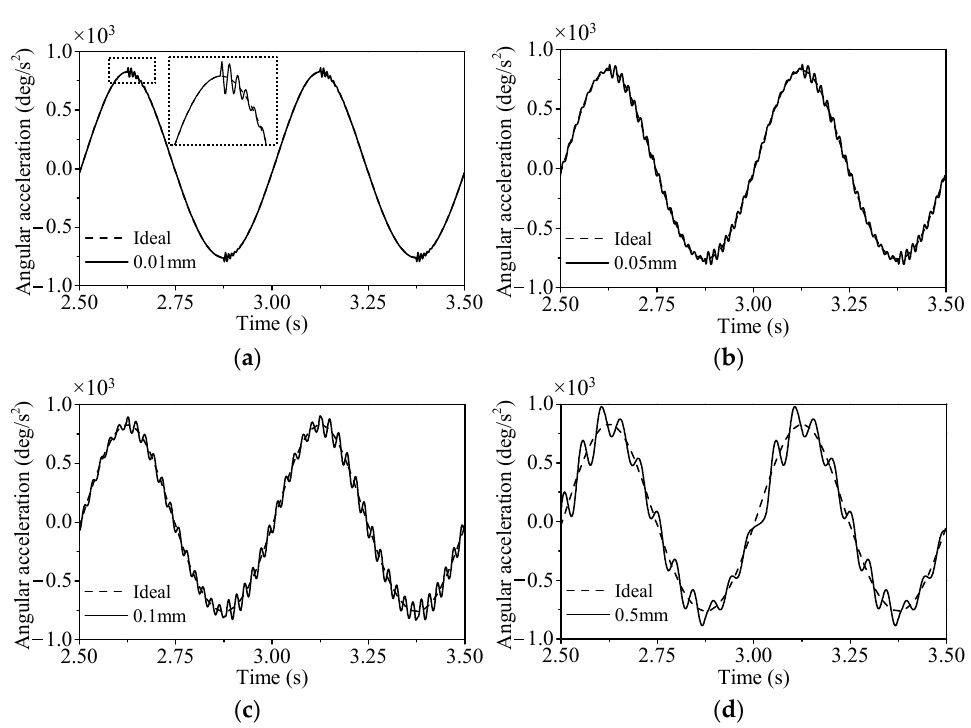
Figure 9. Angular acceleration of the rigid system with different clearance sizes: ( a – d ) clearance size = 0.01/0.05/0.10/0.50 mm.